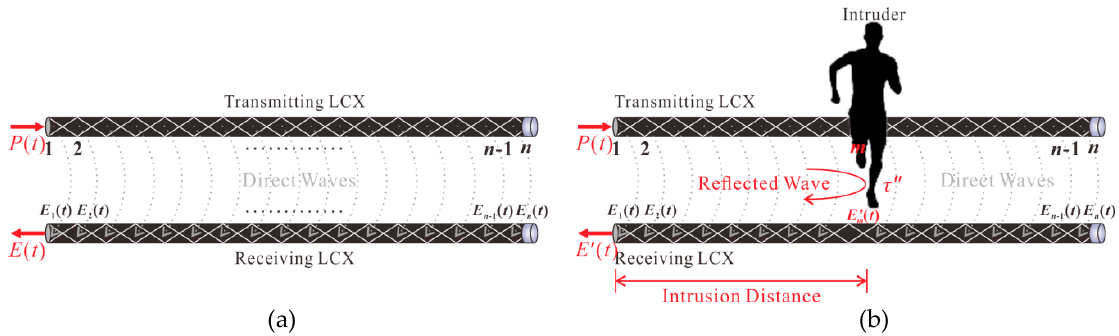
Figure 4. Measurement principle of the proposed LCX sensor ( a ) before and ( b ) after intrusion.